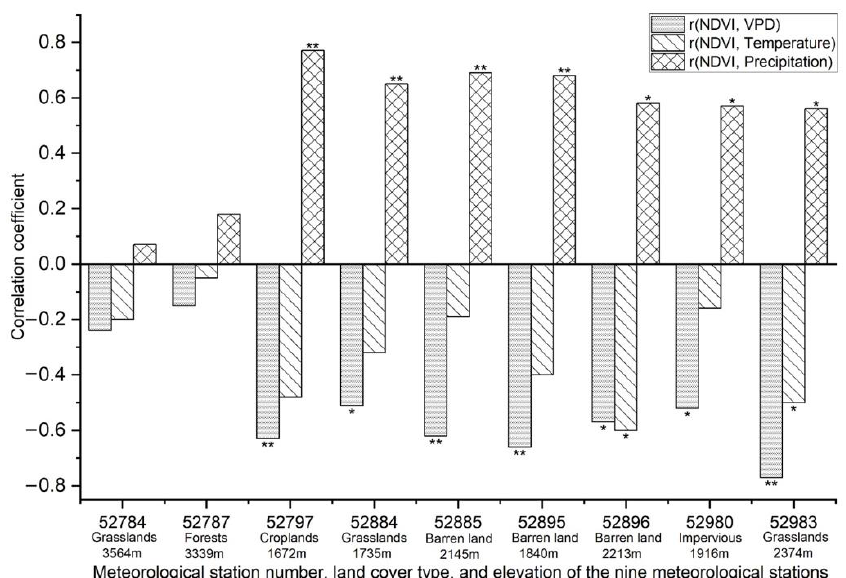
Figure 7. Correlation coefficients between the detrended growing season NDVI and the detrended growing season temperature, precipitation, as well as atmospheric vapor pressure deficit (VPD) at the nine meteorological stations in the period from 2000 to 2016. NDVI at a meteorological station is the average of NDVI values in the 3 by 3 km square collocated with the meteorological station. The meteorological data are from the China Meteorological Data Network [44]. One asterisk indicates that the correlation coefficient is at the 5% level of statistical significance, and two asterisks denote a 1% level of statistical significance.